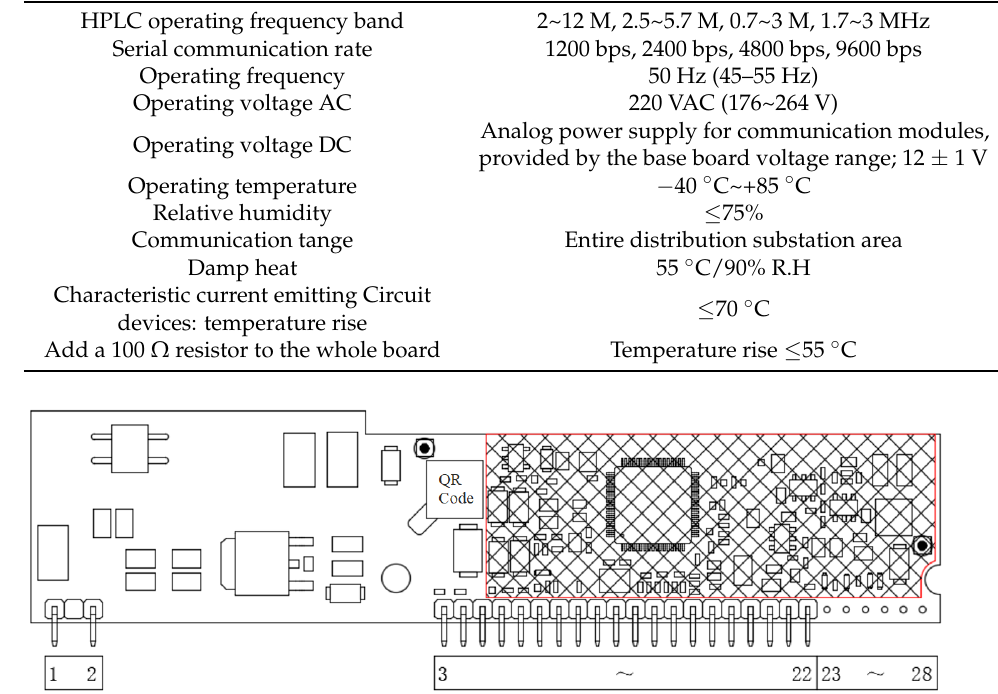
Table 2. Main technical parameters.